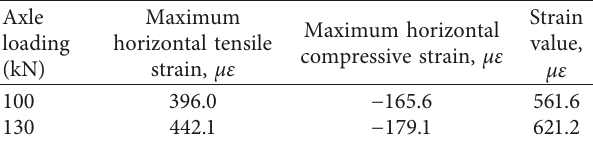
Table 8: Strain of structure 3 in the dual-axle loading mode. Axle loading